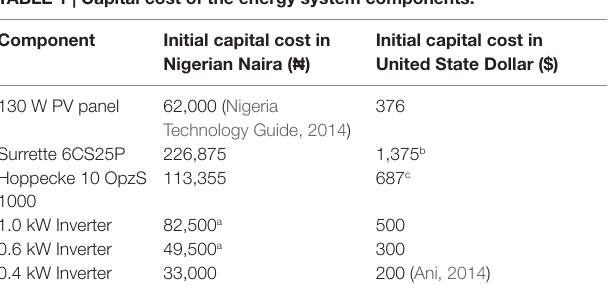
TaBle 1 | capital cost of the energy system